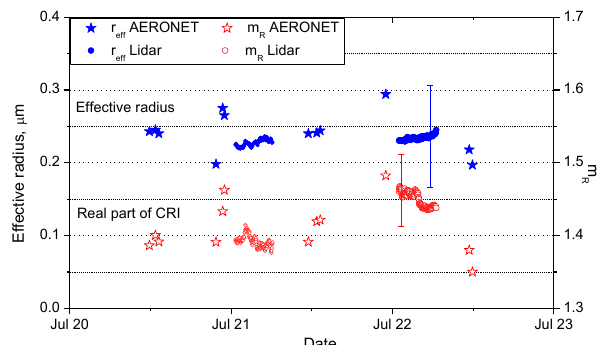
Fig. 11. Effective radius and the real part of the refractive index obtained from AERONET and lidar retrievals during the period of 20–23 July 2011. Lidar retrievals are given for the height layers at 1100 m (21 July) and 1200 m (22 July).